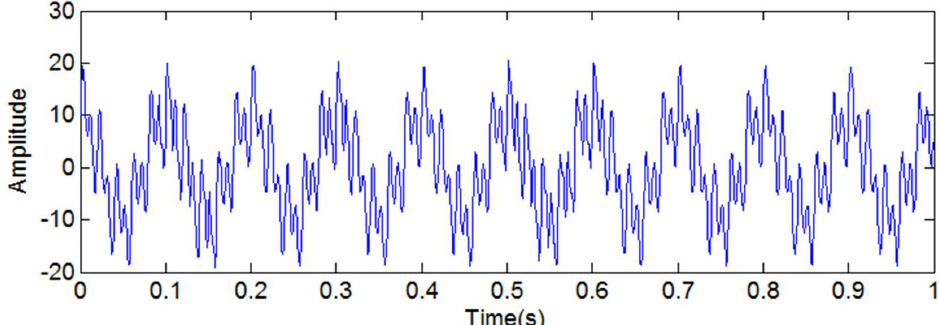
Figure 9. The simulated signal y 3 ( t ).